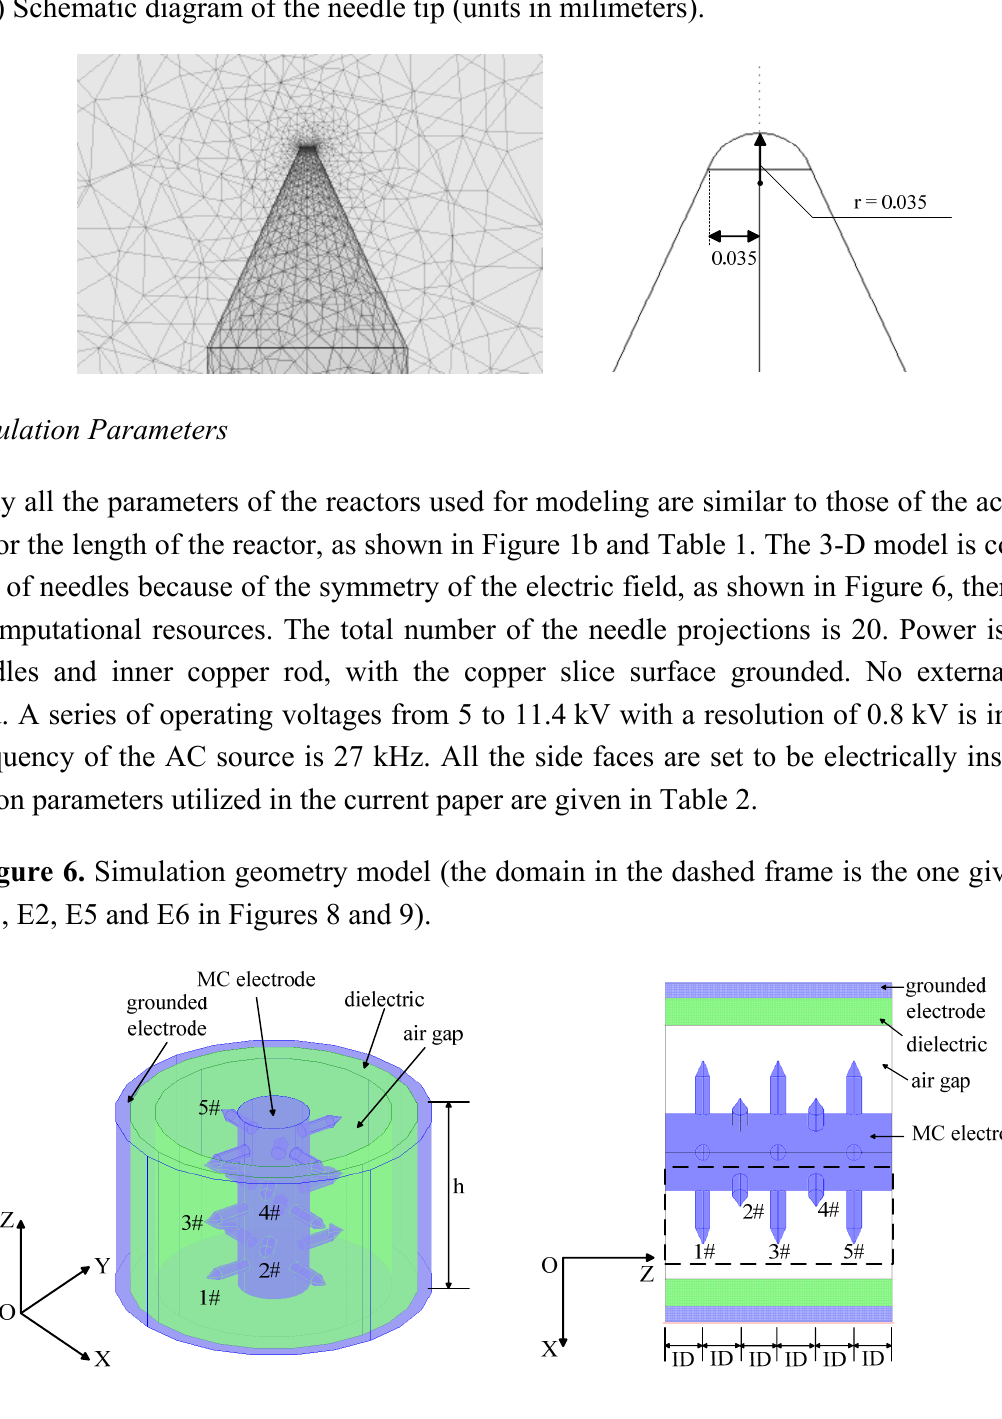
Figure 5. Simulation model of the needle tip: ( a ) Zoomed view of the local mesh; ( b ) Schematic diagram of the needle tip (units in milimeters).